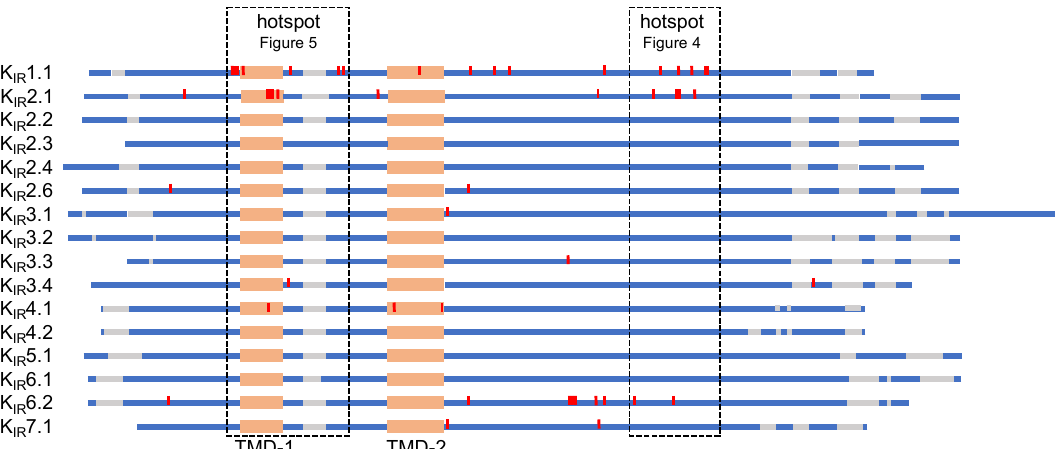
Figure 3. Schematic representation of inward rectifier channels (K IR 1–7) sequence alignment. Red: mutations associated with aberrant trafficking; mutation hotspots are boxed. Orange: transmembrane domain; blue: K IR protein sequence; gray: sequence gap.